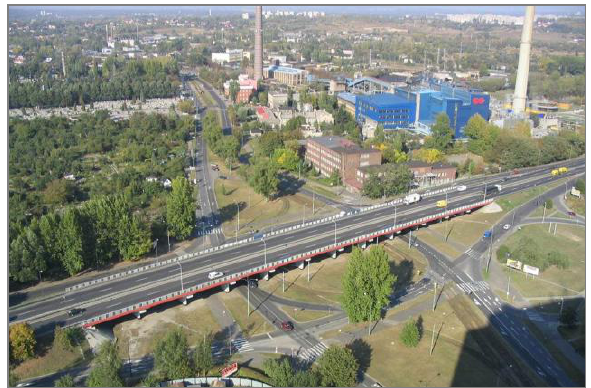
Fig. 1. A typical anthropogenic landscape in Będzin town in the Silesian region, ( U. Myga-Piątek )